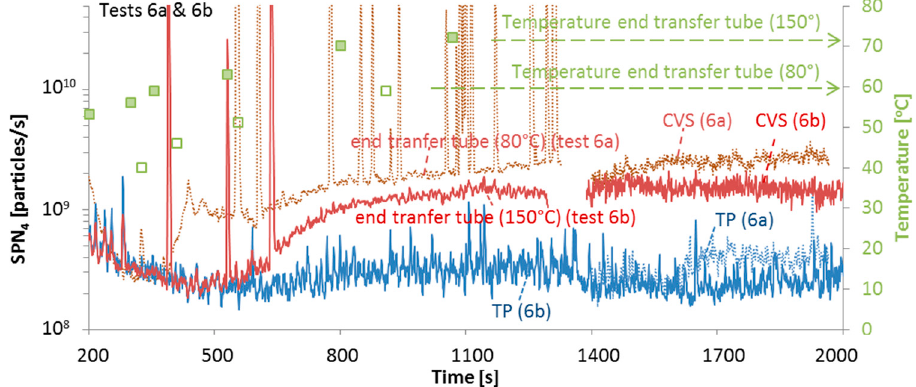
Figure 5. Solid particle number (SPN) emission rates for particles > 4 nm at the tailpipe (TP), the end of the transfer tube heated at 80 °C or 150 °C, and the dilution tunnel (CVS). The temperature at position 2 (end of transfer tube) is also plotted. Tests 6a and 6b.